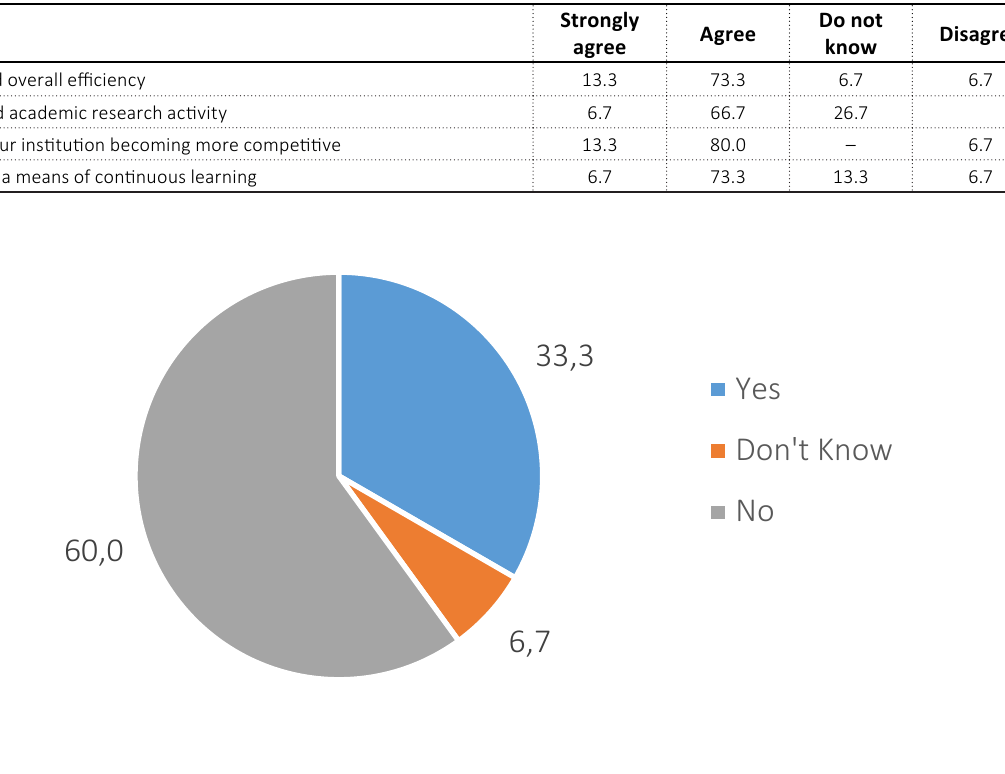
Figure 5. Provision of Knowledge Management Systems to facilitate academic research